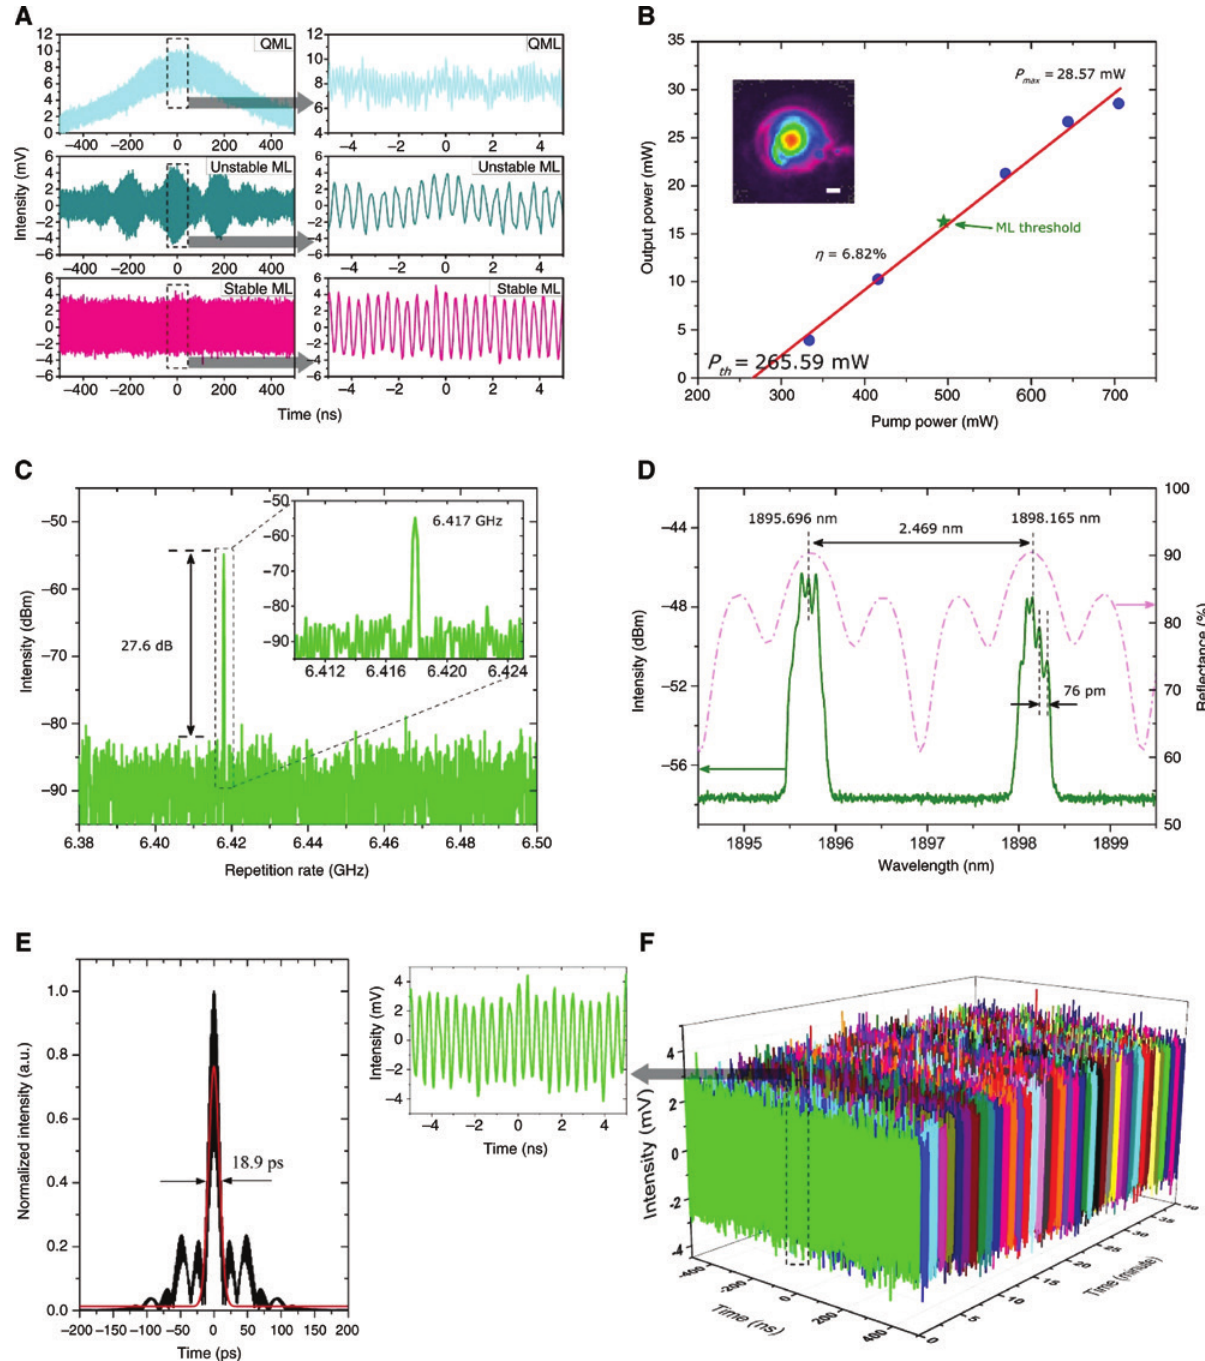
Figure 4: Mode-locked WG laser performance using the ITO absorber. (A) Temporal oscilloscope spectra of Q-switched mode-locked, unstable mode-locked, and stable mode-locked laser operations. The left- hand side shows the spectra on a 1000 ns time scale, and the right-hand side shows the zoomed-in spectra on 10-ns timescale. (B) Average output power as a function of the pump power. Inset: the output beam profile. Scale bar: 1 mm. (C) Radio frequency spectrum of the mode- locking. The inset shows the zoomed-in RF spectrum. (D) Calculated reflection of the TSI agrees well with the output laser wavelength of the mode-locking operation. The air gap width is assumed to be at the adjusting period of 1500471.55 nm. (E) Fast Fourier transform of the mode-locked optical spectrum. The resulting pulse duration is 18.9 ps. (F) Temporal oscilloscope spectra of the mode-locking operation over a time scale of 40